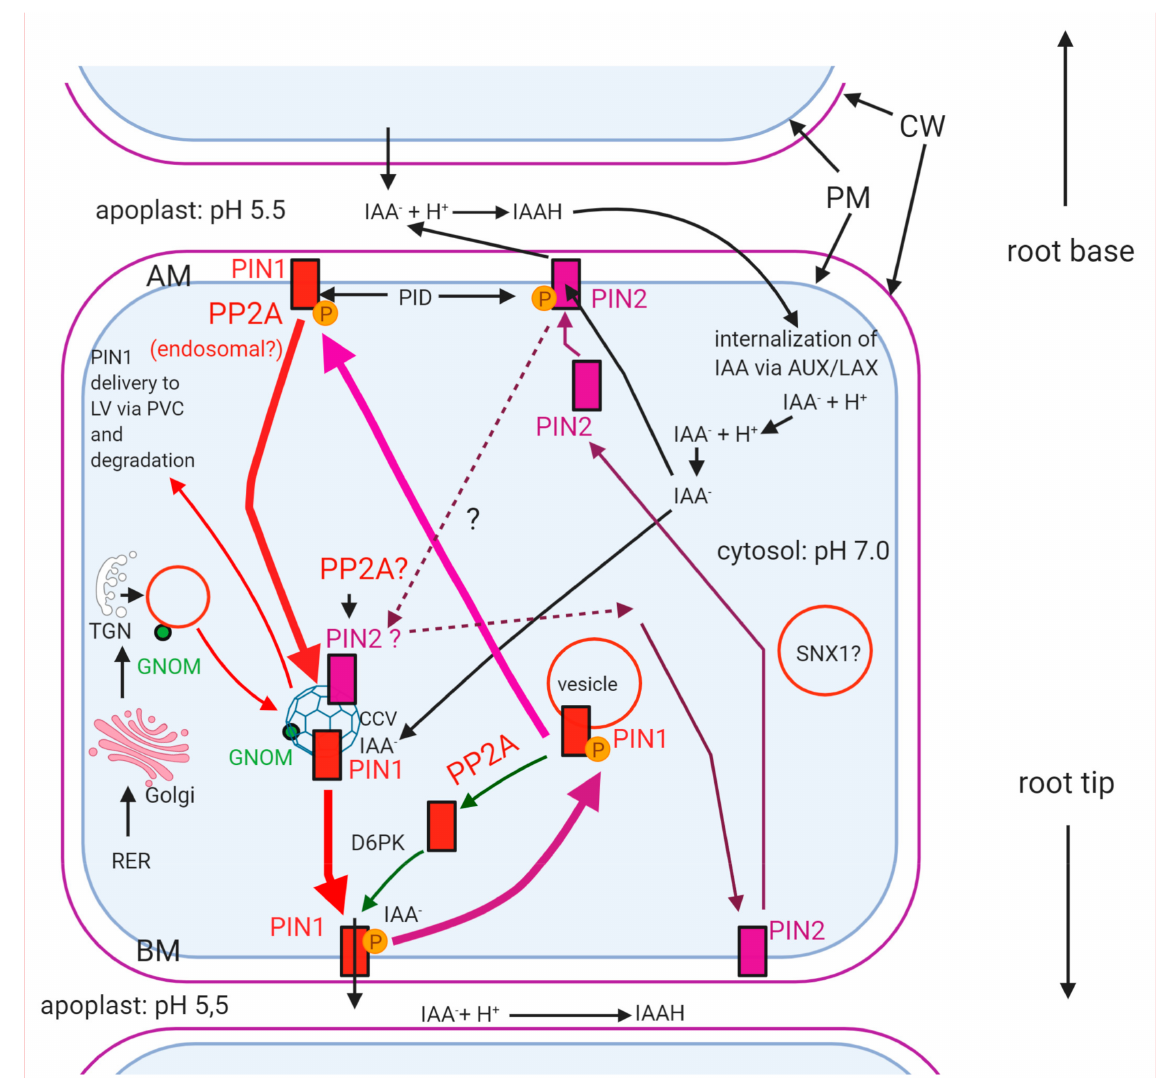
Figure 3. The role of PP2A in functioning, recycling and transcytosis of PINs. Although in general, PIN1 and PIN2 are working in different cells, here we show them in a single cell compartment to show their differential transport and functioning. For simplicity, only vesicle traffic pathways directly or indirectly dependent on PP2A are shown. For example, other GEFs than GNOM and Rab GTPases involved in the traffic of PINs are not shown here. In root epidermal cells, the site of auxin efflux mediated by PIN2 is opposite to efflux mediated by PIN1 in the stele. Pathways of PIN1 and PIN2 polarity shift are partially interfering. GNOM is presumably participating in the transcytosis of PIN1 and PIN2 as well, but for PIN2, this happens mainly in root cortex cells where it directs auxin transport towards the root apex. GNOM pathway-mediated transport of PIN2 towards basal membrane for recycling purposes is probable (dashed purple arrows) but needs further evidence. Both PIN-mediated auxin efflux and their vesicular transport are dependent on protein phosphorylation. PINOID kinase (PID) phosphorylates both PIN1 and PIN2 at the apical membrane, while D6PK kinase phosphorylates PIN1 in the basal pole of a root cell. PP2A dephosphorylates PIN1 and presumably PIN2 at the apical pole and PIN1 at the basal pole. Question marks show yet not fully investigated events. At the basal membrane, PIN2 might be phosphorylated by a yet unknown kinase and if it remains in a phosphorylated state here, its recycling will be impeded. → (Red arrow) GNOM dependent transcytosis of PIN1 in the apical-basal direction. → (Pink arrow) Basal–apical shift of PIN1 is independent of GNOM. → (Purple arrow) The pathway of intracellular PIN2 traffic. Thick arrows highlight the transcytosis and recycling pathway of PIN1. AM—apical membrane; BM—basal membrane; LV—lytic vacuole; PVC—prevacuolar compartment (multivesicular body/late endosome); SNX1—SORTING NEXIN1 containing vesicle; the figure was constructed with the aid of